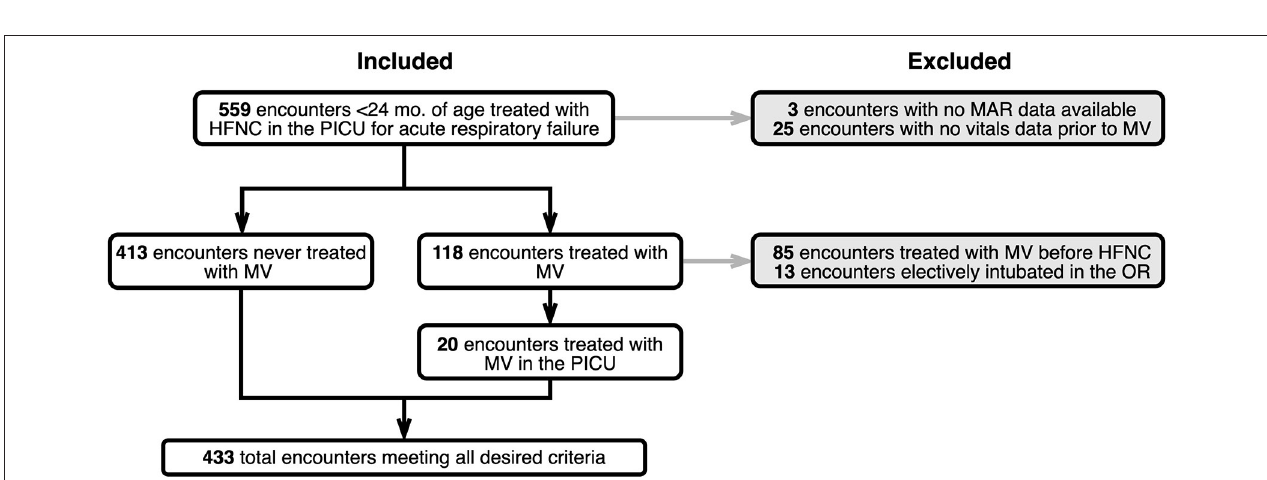
FIGURE 2 | Comparison of ROX index for a hypothetical patient with S p O 2 ≥ 97% given two different clinician approaches. In Scenario 1, the clinician does not decrease the patient’s F i O 2 , resulting in a low ROX index. In Scenario 2, the clinician decreases the patient’s F i O 2 appropriately, resulting in a higher ROX index than Scenario 1, despite the patient’s identical health status.